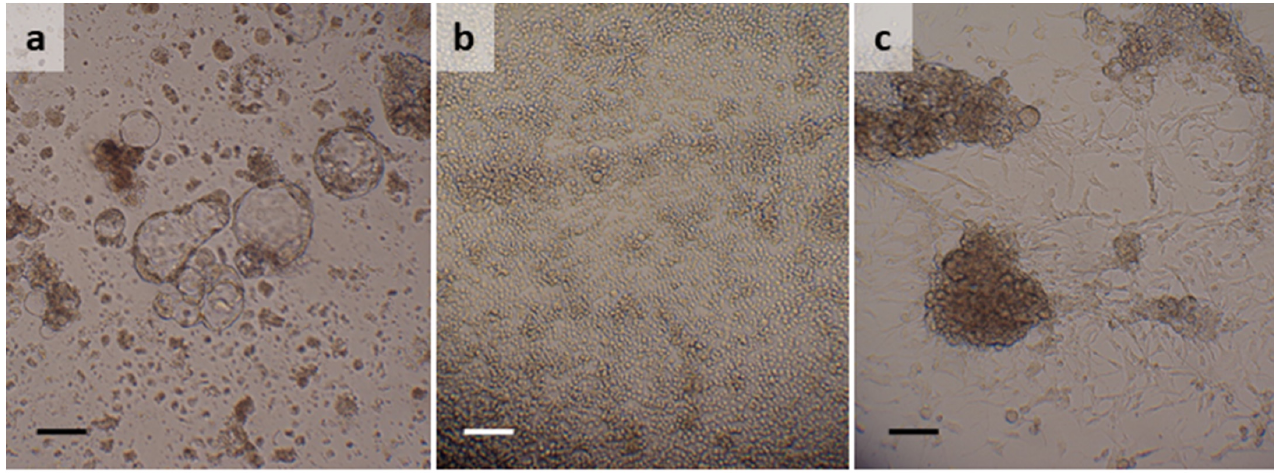
Figure 3. Ixodes ricinus and Rhipicephalus bursa cell lines. ( a ) I. ricinus cell line IRE/LUAP46 at passage 3, 7 years after initiation; ( b ) I. ricinus cell line IRE/LULS55 at passage 19, 44 months after initiation; ( c ) R. bursa cell line RBE/LULS58 at passage 3, 4 years after initiation. Live, inverted microscope, scale bars = 100 µm.